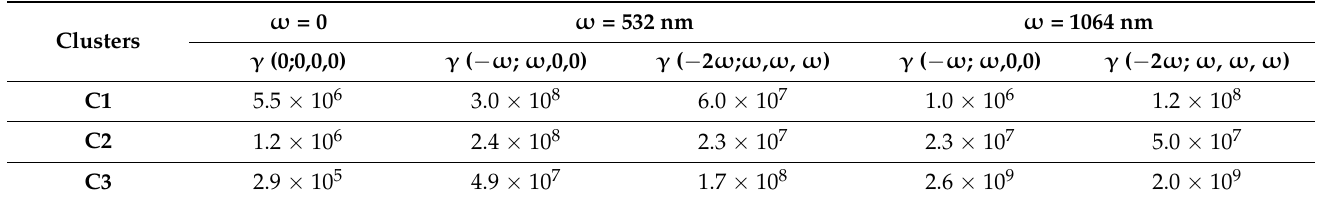
Table 6. Static second hyperpolarizability ( γ o in au), frequency-dependent second-hyperpolarizability γ ( ω ) in term of electro-optic-pockel’s effect (EOPE) γ ( − ω ; ω , 0) in au, and electric